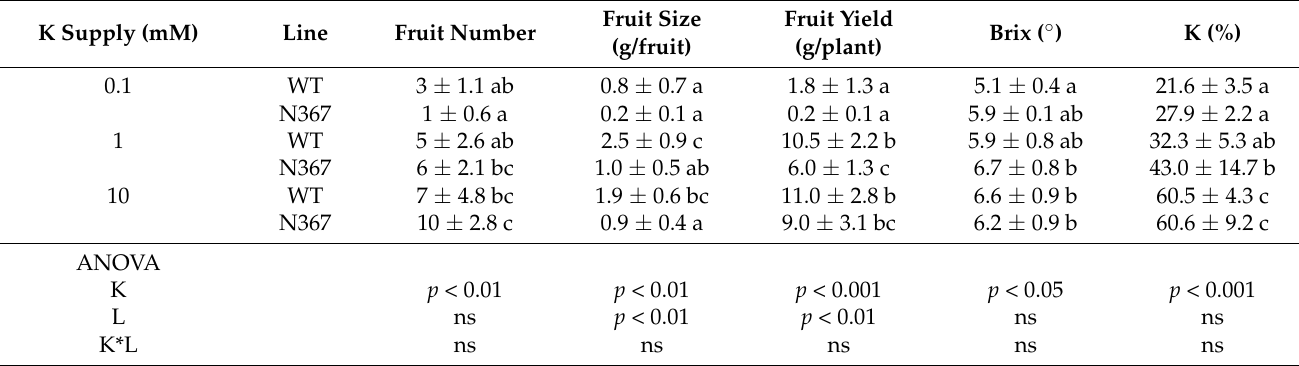
Table 2. Effects of K supply on fruit yield, solute contents (Brix degrees) and fruit K concentration in two lines (wild-type (WT) and N367) differing in K uptake after six cycles of limited watering (see Section 2). Means followed by the same letter are not significantly different (LSD Test, p < 0.05). K and L in ANOVA represent potassium and line factors, respectively.